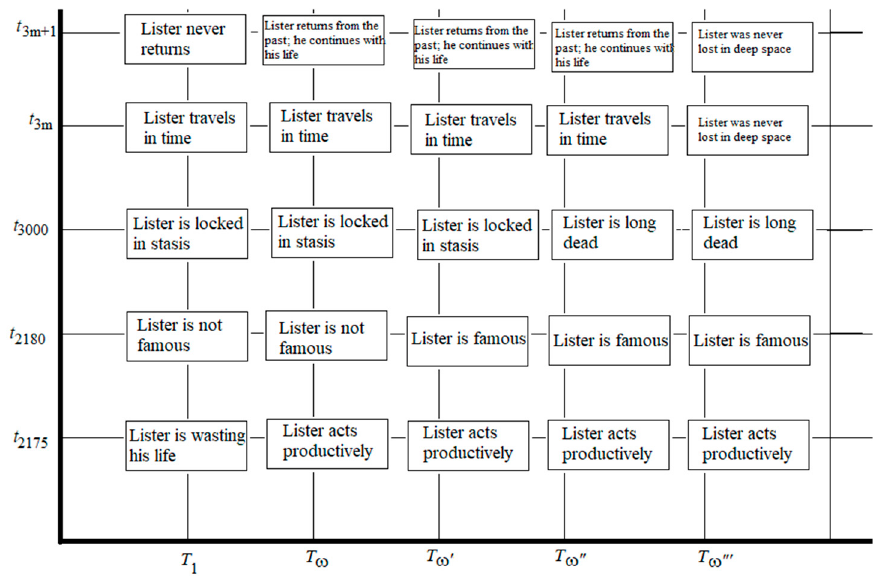
Figure 4. The narrative of Red Dwarf ’s ‘Timeslides’.